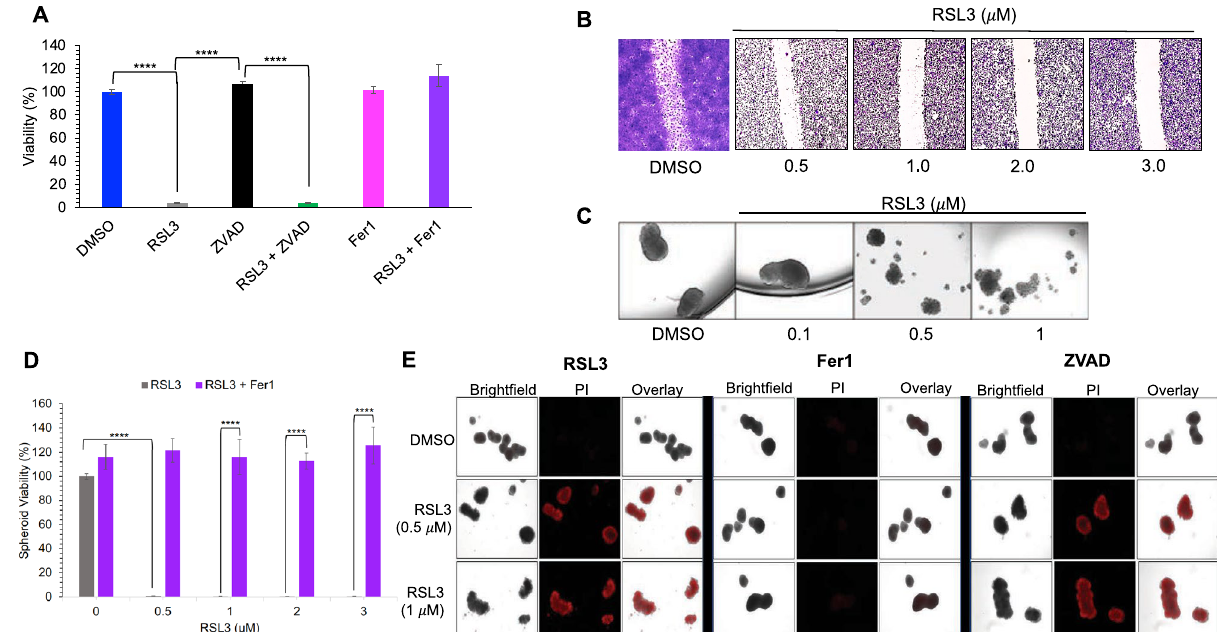
Figure 3. RSL3 suppresses K1 cell viability, K1 tumor cell spheroid formation and viability, and arrests thyroid tumor cell migration in vitro. ( A ) Viability of K1 cells treated with RSL3 (2 μM), Fer1, ZVAD, and combination of RSL3 with Fer1 or ZVAD. ( B ) Representative microscopy image showing arrested K1 cell migration after RSL3 treatment (× 10 magnification). ( C ) Representative microscopy image showing impaired spheroid formation of K1 cells after RSL3 treatment (× 20 magnification). ( D ) Viability of spheroids treated with RSL3 and Fer1 for 48 h were assessed (* p < 0.05, ** p < 0.01, *** p < 0.001, **** p < 0.0001, ns— p > 0.05). ( E ) Representative microscopic images showing propidium iodide (PI) staining of K1 spheroids treated with RSL3, Fer1 and ZVAD for 48